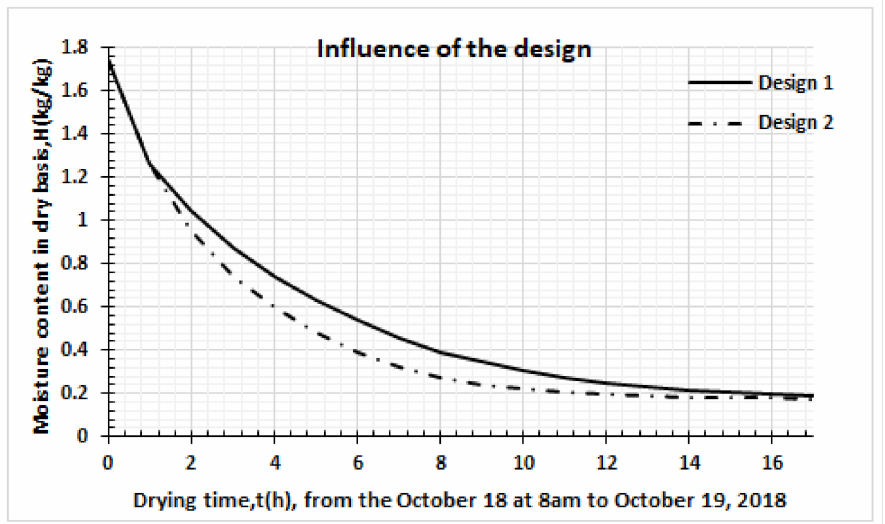
Figure 6. Influence of the design on the drying kinetic in Yamoussoukro, October 2018, designs 1 and